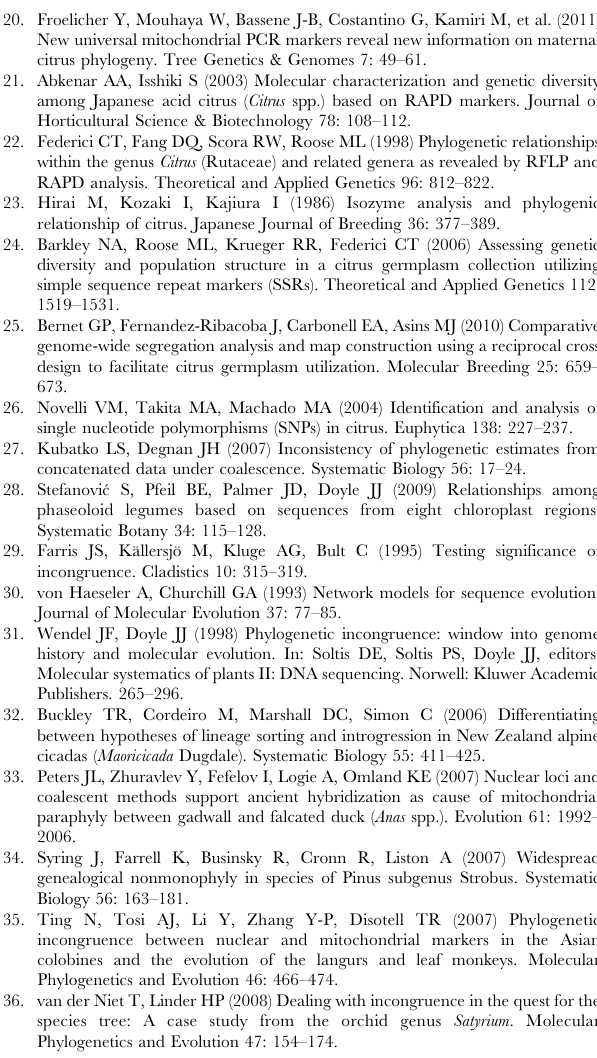
Table S5 Accessions included in the STRUCTURE analysis. For the SSR analysis, we included a subset of 212 accessions from a total of 370 accessions reported by Barkley et al (2006). Many hybrids were excluded from the analysis. Accessions with an asterisk (*) were also included in the SNP analysis.